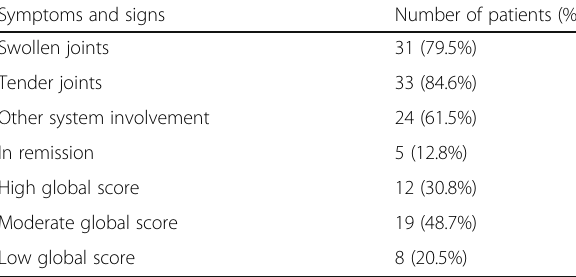
Table 2 Clinical criteria of RA